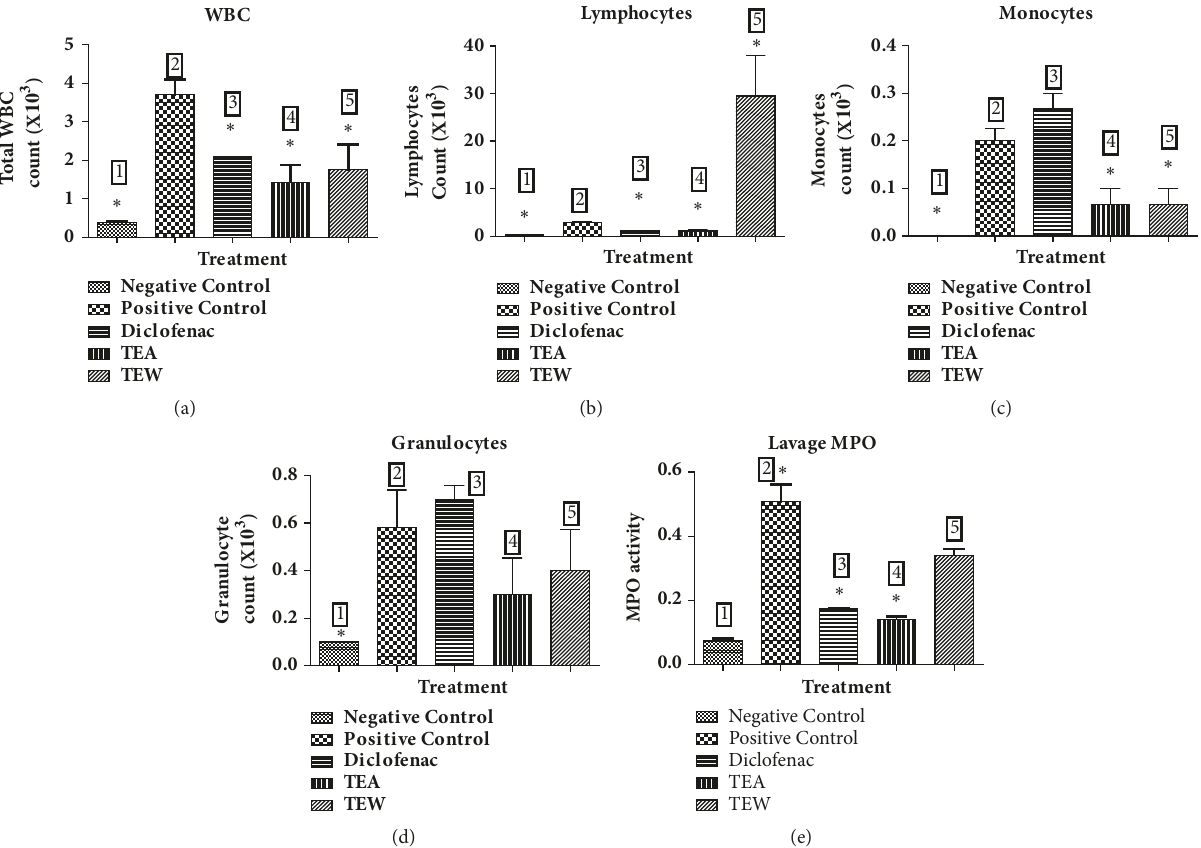
Figure 4: Carrageenan-induced air pouch inflammation in Wistar rats: (a) total WBC count, (b) % lymphocytes count, (c) % granulocytes count, (d) % monocytes count, and (e) MPO activity. 1: negative control, 2: positive control, 3: diclofenac, 4: TEA, and 5: